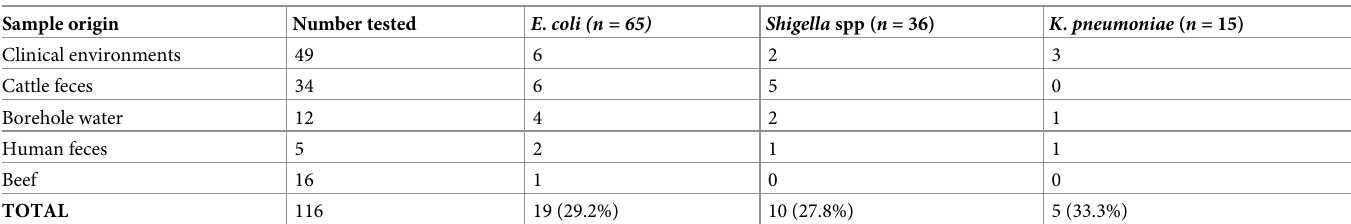
Table 5. Prevalence of ESBL-producing Enterobacteriaceae .